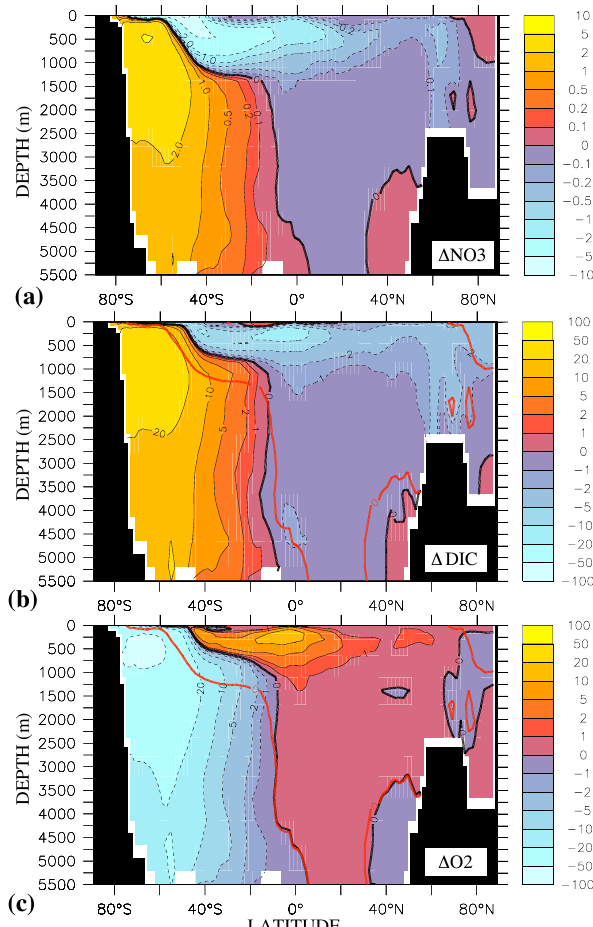
Fig. 3. Zonally averaged change in (a) simulated annual-mean ni- trate concentrations, (b) simulated annual-mean dissolved inorganic carbon concentration, and (c) dissolved oxygen concentrations of the 100-year OIF run minus control run in year 2110. Units are mmolm − 3 . The red lines in (b) and (c) denote the zero nitrate- change isoline of (a)